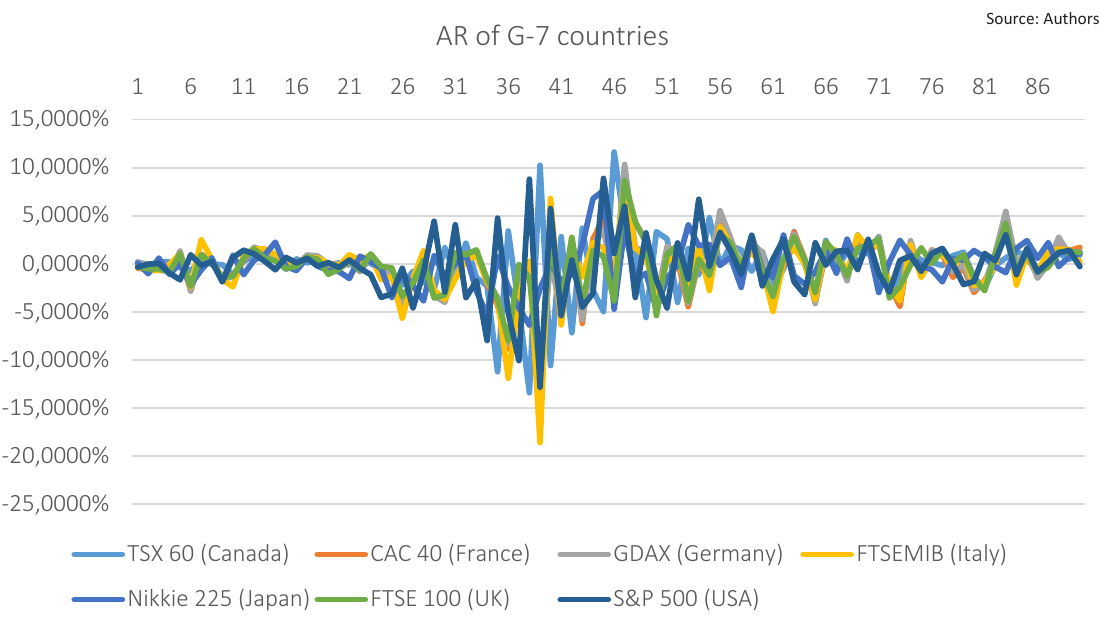
Figure 1. Abnormal returns for G-7 in the observation window (0-89)